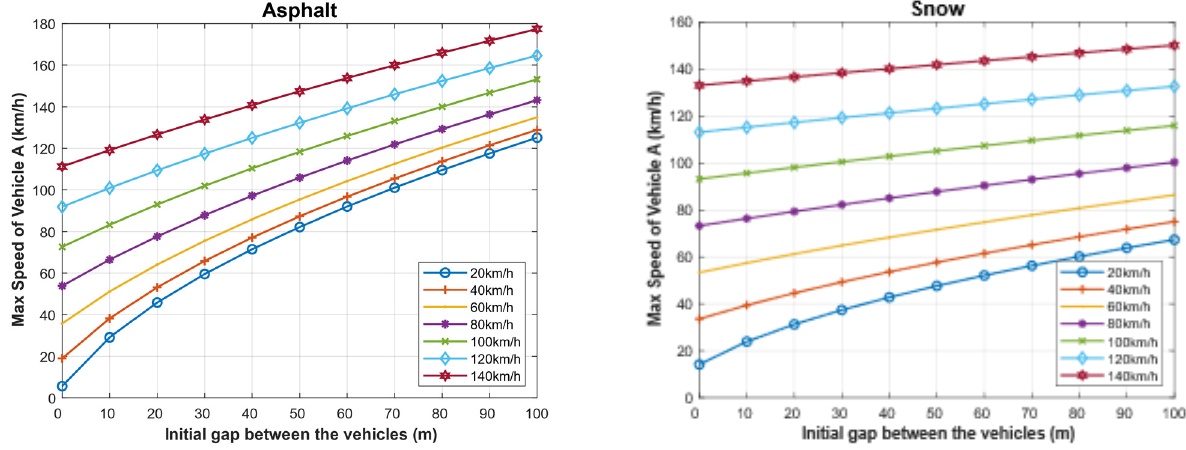
Figure 14. Maximum speed of the following vehicle for different speeds of the followed vehicle for different initial distances between the two vehicles when the driver reaction ( T rA = 1 s). We calculated the same values in the case of foggy weather, as shown in Figure 15.